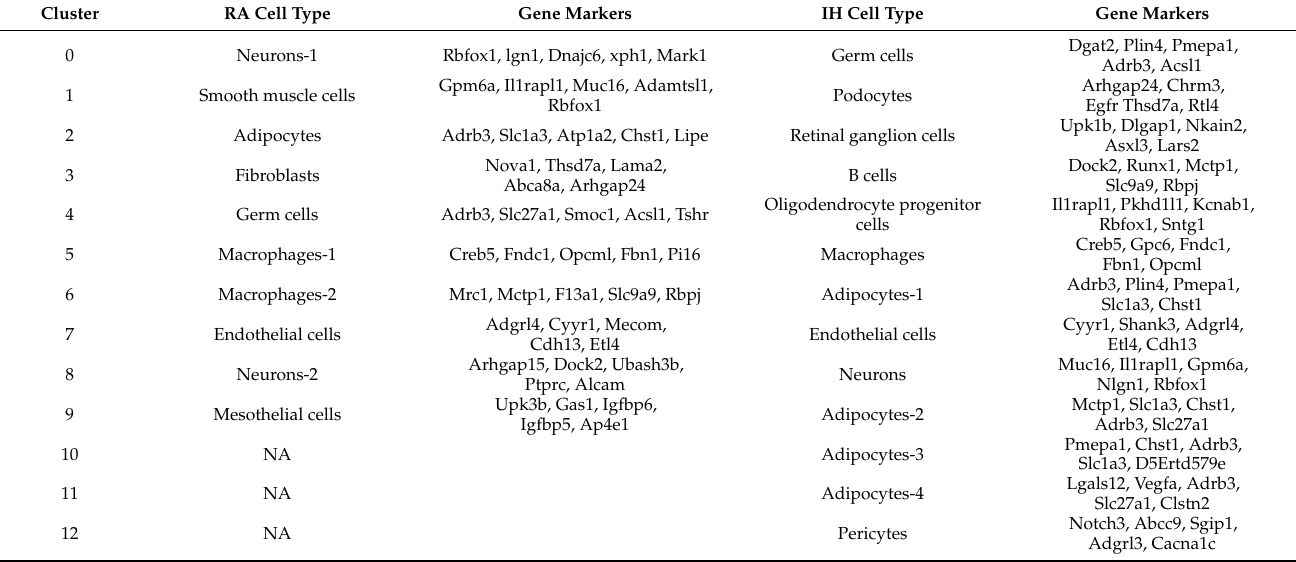
Table 1. Cell types with their top 5 gene markers for vWAT in mice as separately determined for mice exposed to IH or RA. Cluster